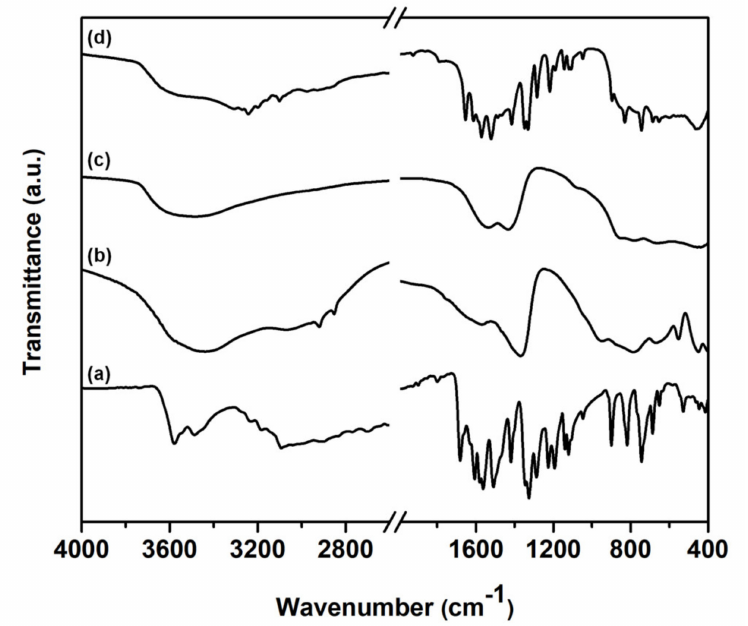
Figure 2. Fourier transform infrared (FT-IR) spectra of ( a ) intact NIC, ( b ) HT, ( c ) DHT, and ( d ) NIC– DHT nanohybrids.